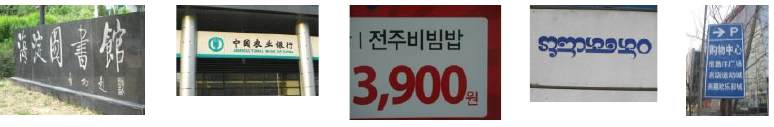
Figure.15. Variability in MLe2e dataset.